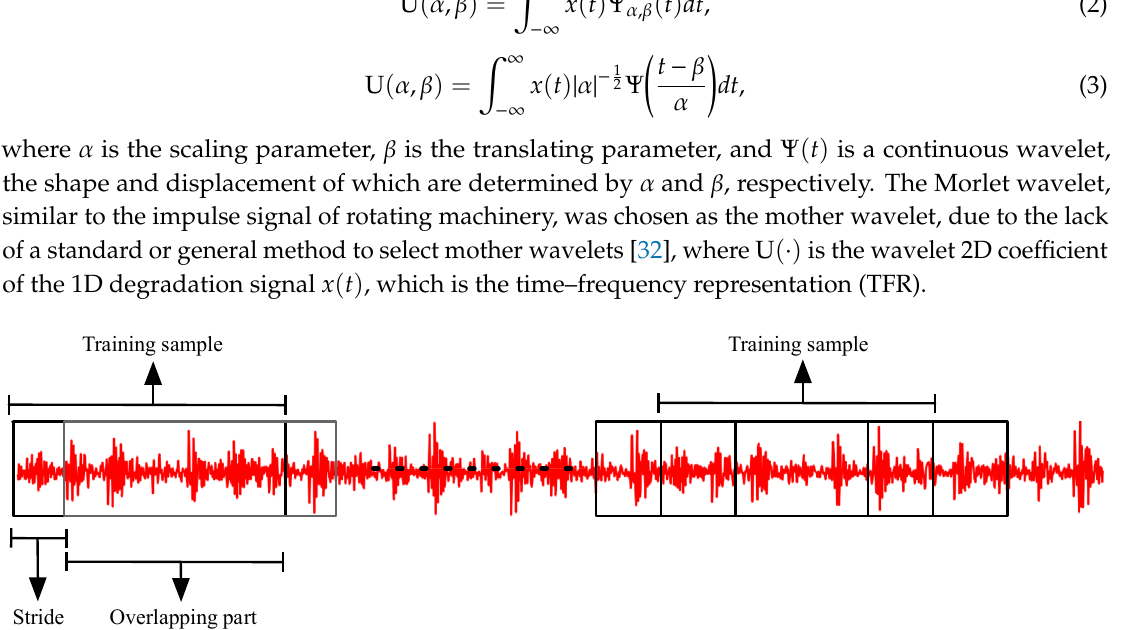
Figure 2. The samples generated by enhanced sampling.